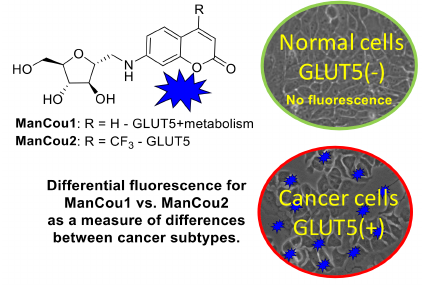
Figure 1. Fluorescence-based identification of breast cancer cells and discrimination of cancer phenotypes through GLUT5 with fluorescent 1-AM-coumarin conjugates ManCou1 and